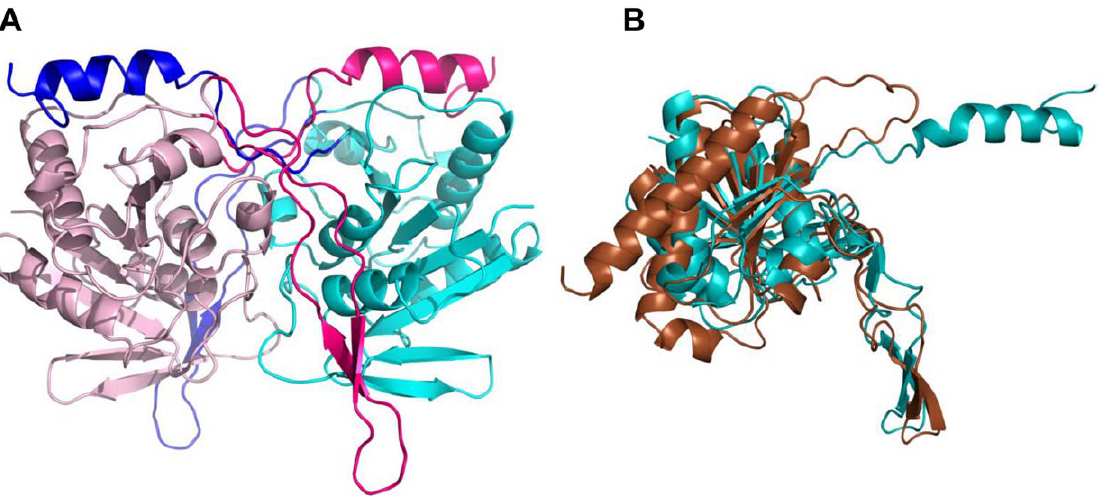
Figure 1. SurE structure. A) Structure of wild type St SurE dimer shown in ribbon representation. Chain A is in light pink while chain B is in light blue. The swapped C-terminal helices (residues 227–253) and tetramerization loops (residues 179–210) of A and B chains are shown in darker shades. B) Structural superposition of St SurE (blue) and Pa SurE (brown) protomers. C-terminal helices are swapped in St SurE but not in Pa SurE, where a reversal of polypeptide that occurs before the C-terminal helix could be